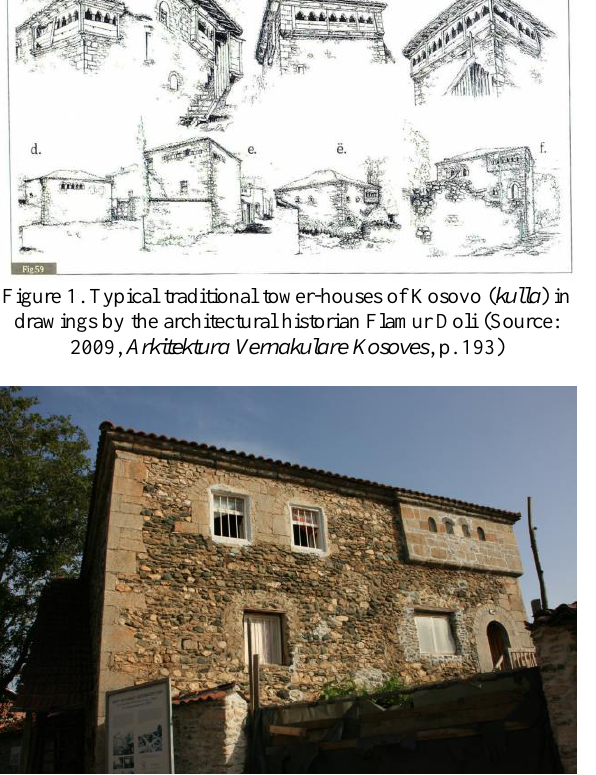
Figure 2. Typical traditional tower-house ( kulla ) in Dranoç, Western Kosovo (Photo: Jaeger-Klein, May